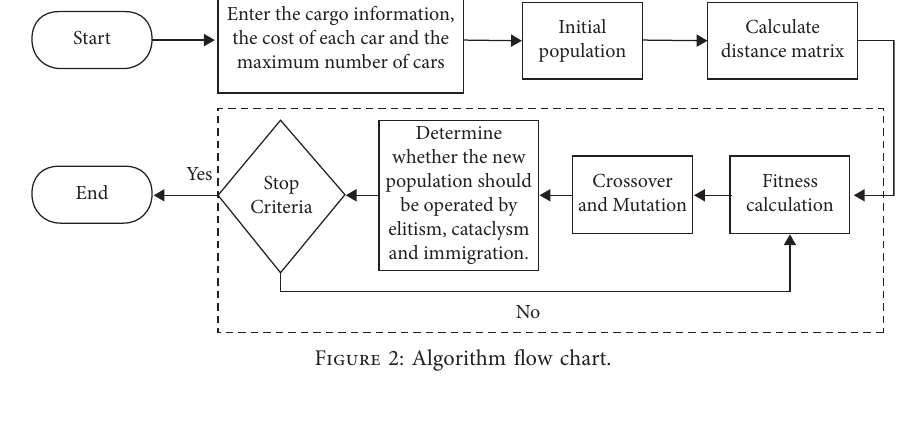
Figure 2: Algorithm flow chart.